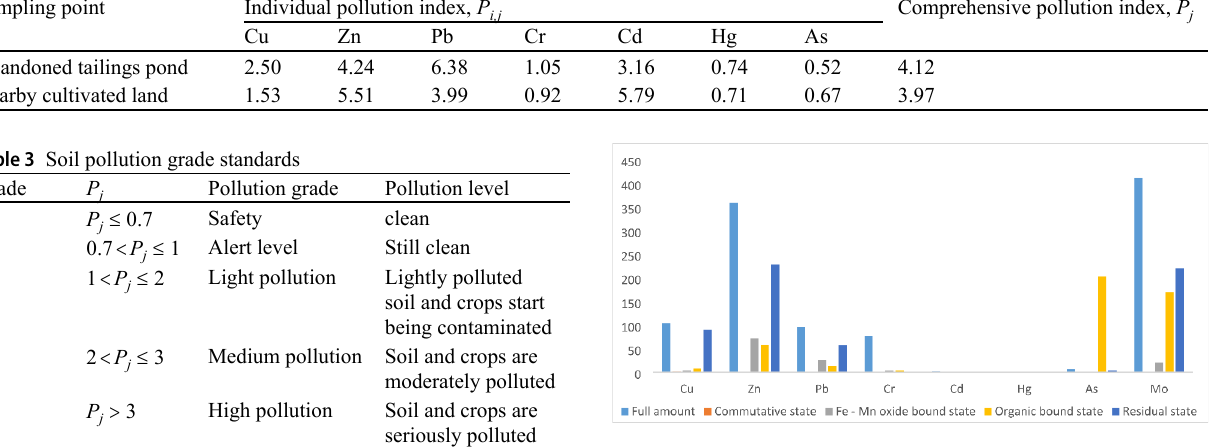
Table 4 Data from Chinese Standards of Soil Environmental Quality or Soil Pollution Risk Control on Agricultural Land (Trial) (GB15618- 2018) (mg/kg)